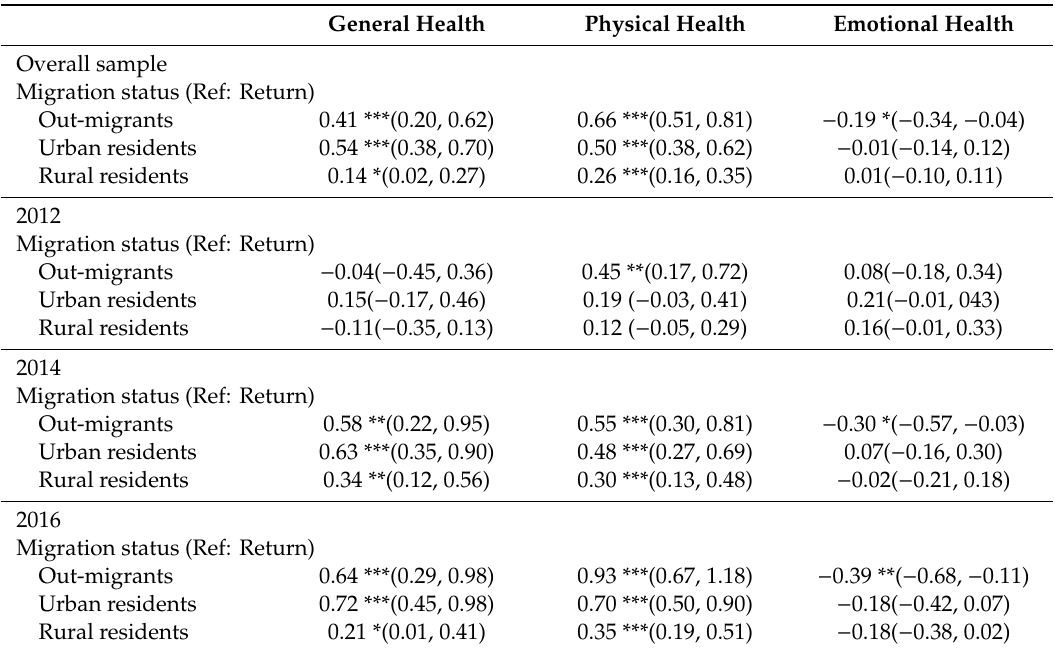
Table 4. Marginal e ff ects of migration status (comparing with returned